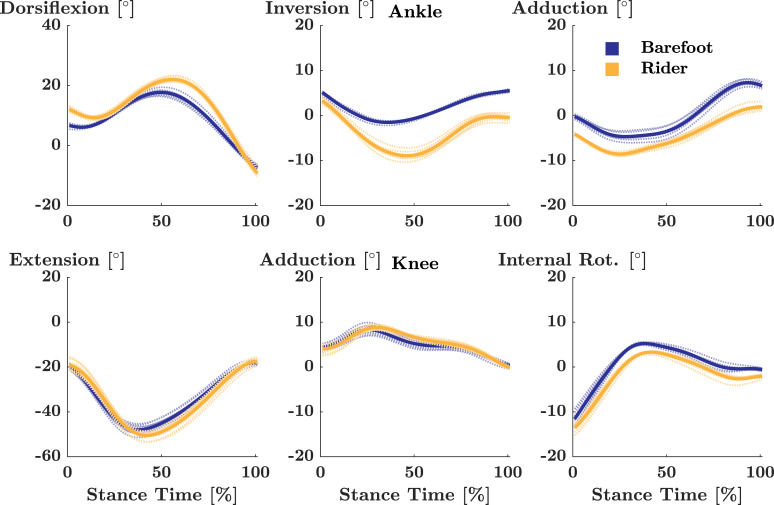
Exemplary ankle and knee joint kinematics in Barefoot and Rider.Time normalized mean (solid) and individual (dotted) joint kinematics for the ankle (top) and knee (bottom) of a representative participant in barefoot (blue) and rider (yellow).